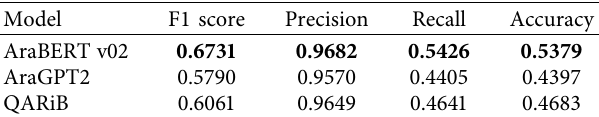
Figure 2: Comparison of precision, recall, accuracy and F1 scores for models applied on the validation dataset (ArCOV19-Rumors, ANS, and Table 3: FND model performance on COVID-19-FAKES dataset.